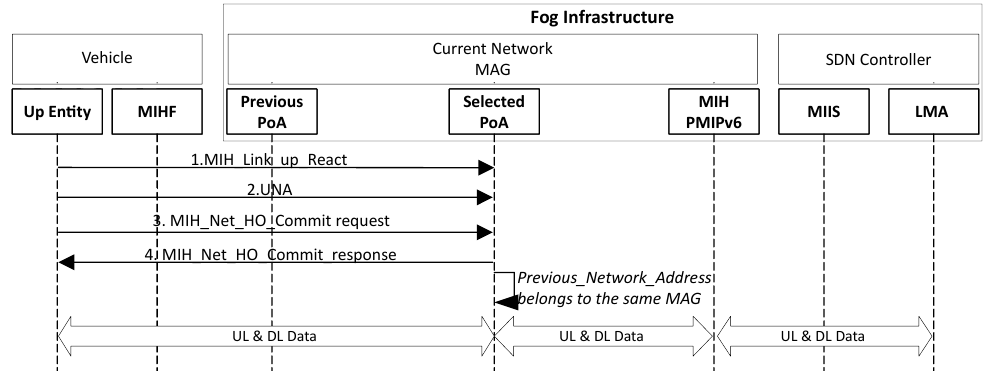
Figure 12. The intra-MAG reactive VHO